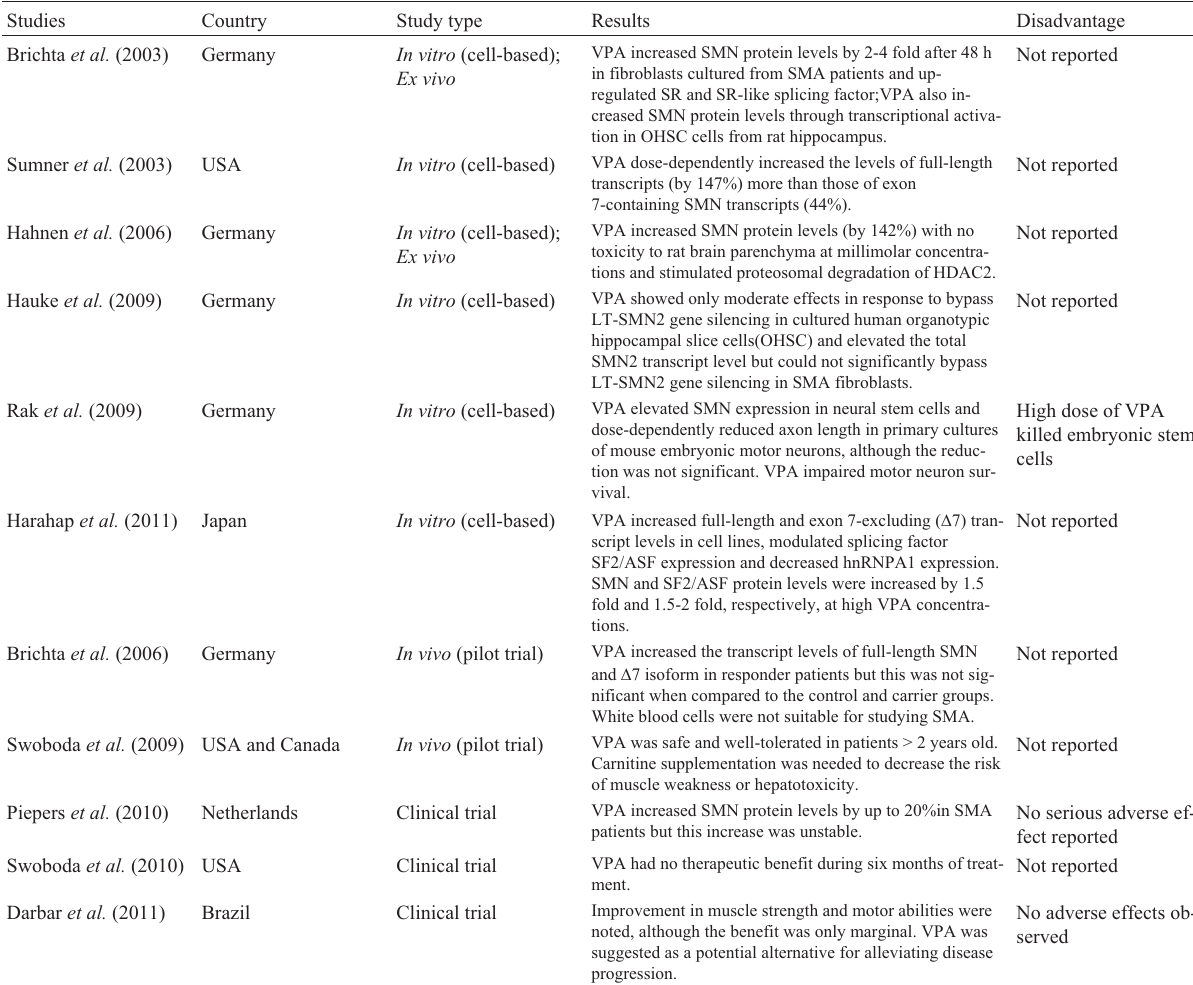
Table 2 - Summary of studies on valproic acid (VPA) for the treatment of spinal muscular atrophy.